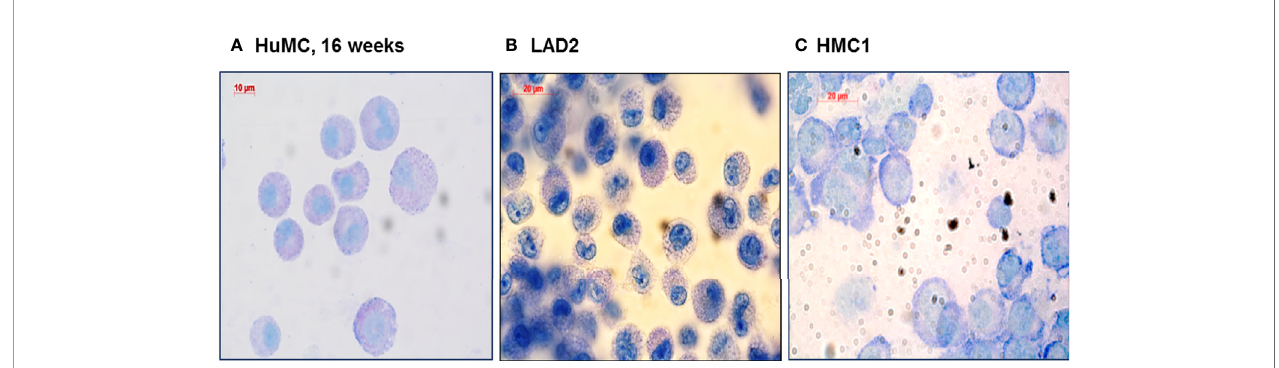
FIGURE 2 | Morphologic appearance of different mast cell lines: HuMC, LAD2, HMC1. Toluidine blue staining of HuMC (A) and LAD2 (B) show a typical granular pattern. HMC1 (C) shows a different morphology as compared to HuMC and LAD2, in particular, granules are